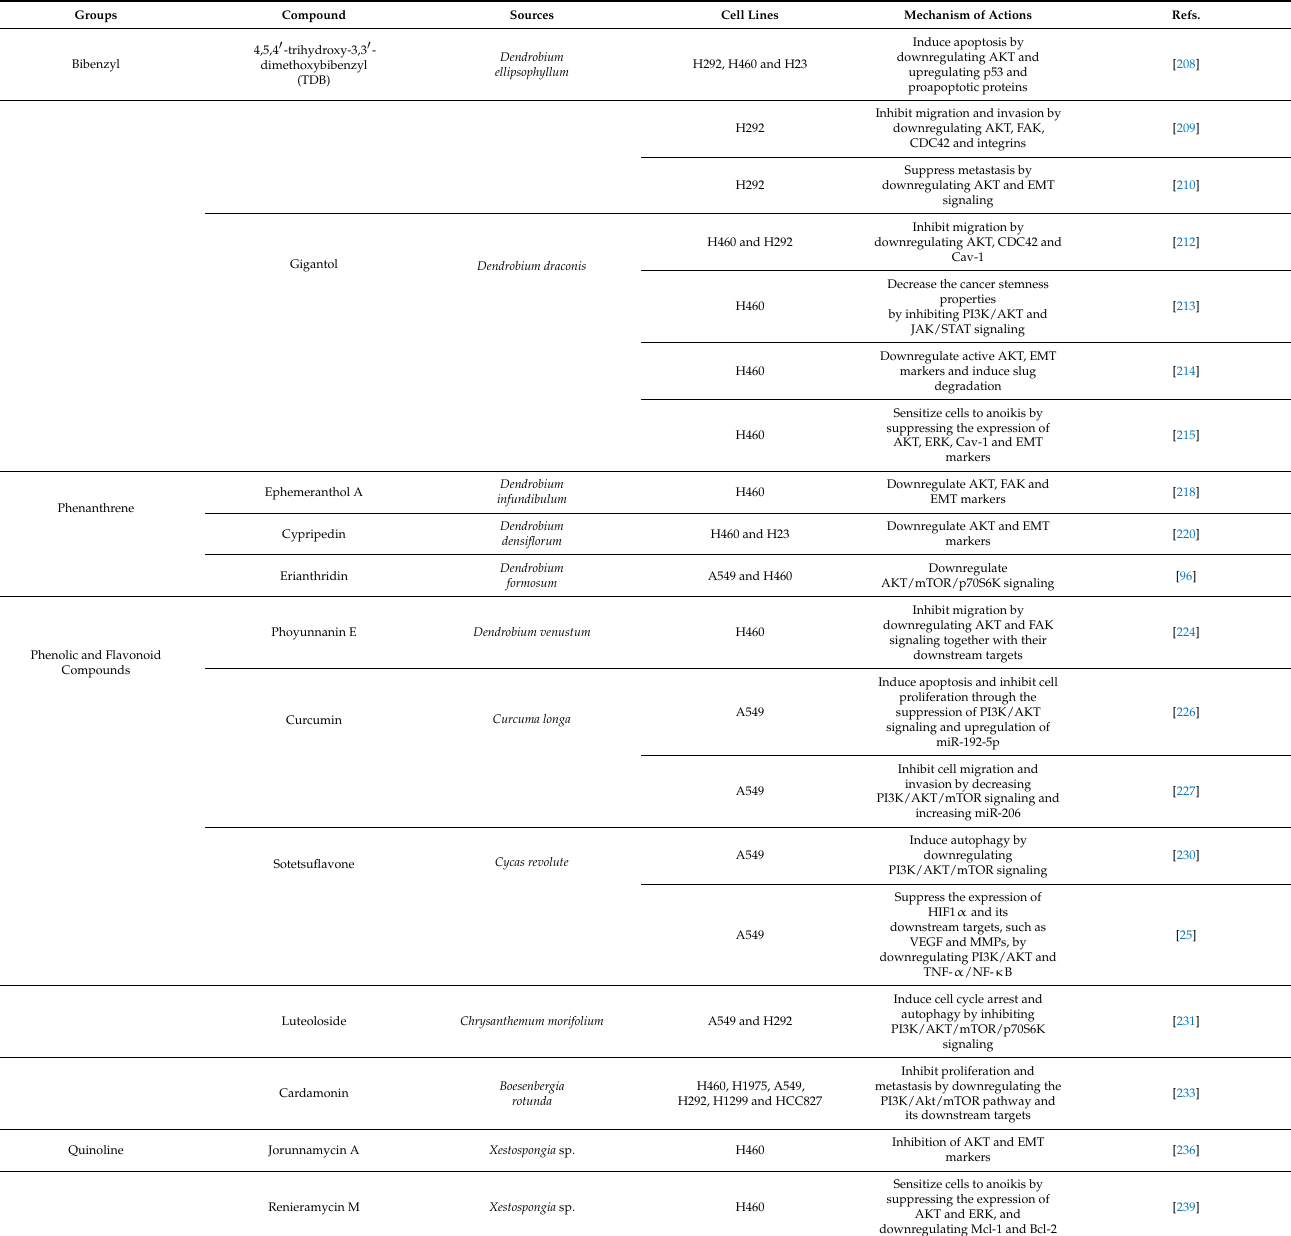
Table 2. Preclinical investigation of several natural products targeting the PI3K/AKT/mTOR signaling pathway in lung cancer. Groups Compound Sources CellLines MechanismofActions